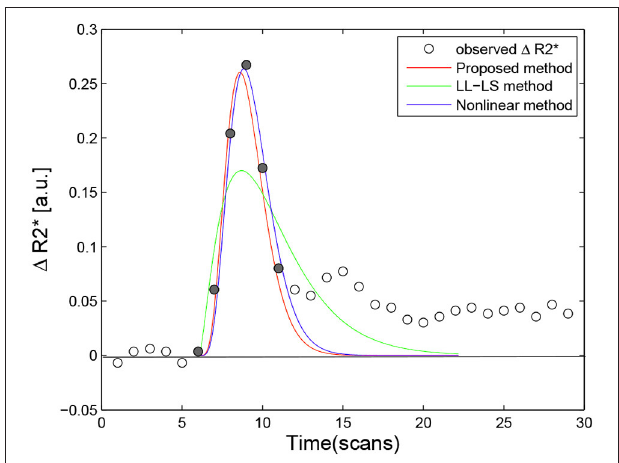
FIGURE 3 | Example of fitting curve obtained using the proposed method (red line, α mle 5.8943, β mle 1.6095, F mle 2.4427), the LL-LS method (green = = = line, α ls 2.4364, β ls 5.6789, F ls 3.0727), and the nonlinear method (blue = = = line, α non 6.0289, β non 1.7118, F non 2.5780) for a single voxel. Filled = = = circles denote valid data points for perfusion-curve fitting; other points are indicate by hollow